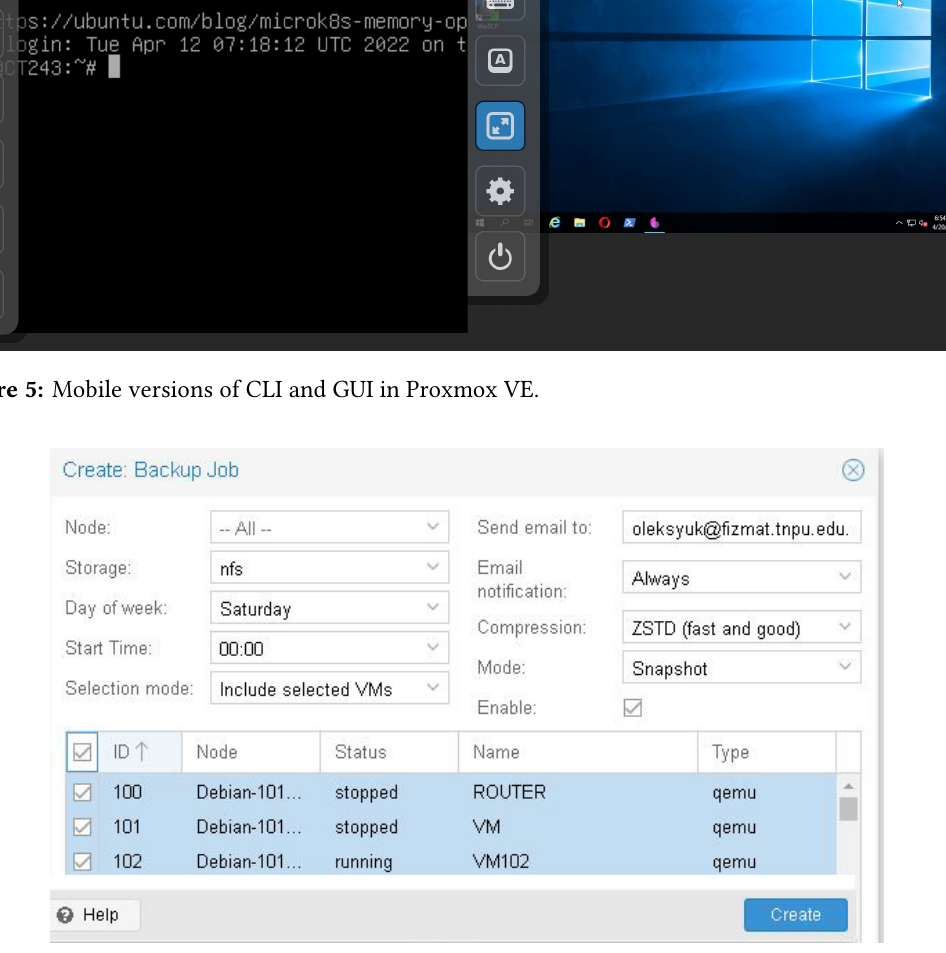
Figure 6: Scheduled backup